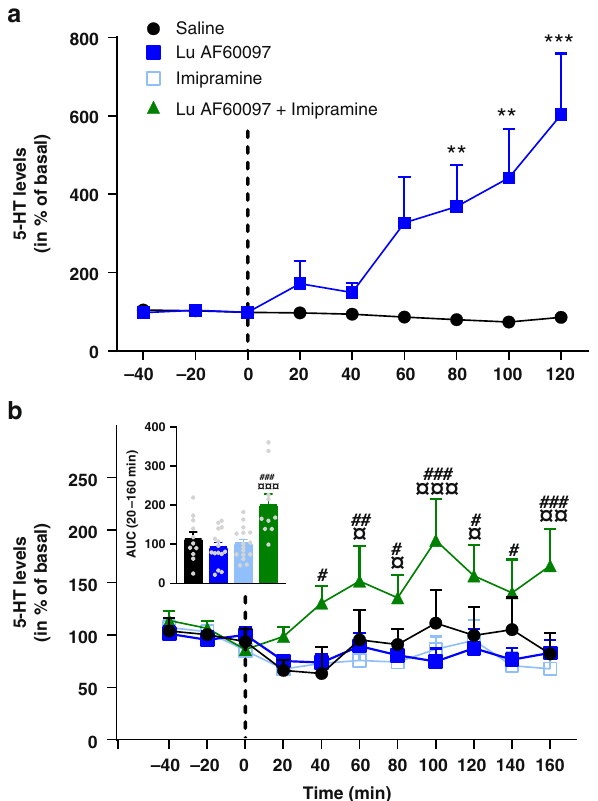
Fig. 6 Effects of Lu AF60097 and imipramine on 5-HT levels in rat hippocampus. a Changes in extracellular 5-HT levels after injection (dotted line) of 1 µ l (250 nM) Lu AF60097 (squares) or saline (circle) in ventral hippocampus of freely moving rats. The 5-HT levels show a continuous increase at all time points after the 40 min post injection bin to a maximum of 602 ± 156% of basal level (data are means ± S.E.M., n = 6). b Hippocampal perfusion of Lu AF60097 and imipramine synergistically increases extracellular 5-HT levels. Extracellular 5-HT levels were determined 40 min prior and 160 min after initiating (dotted line) a continuous perfusion of either saline (aCSF, circles), 1.9 µ M Lu AF60097 (closed squares), 0.36 µ M imipramine (open squares), 1.9 µ M Lu AF60097 + 0.36 µ M imipramine (triangles) in ventral hippocampus of freely moving rats. Inset: Area under the curve during perfusion (20 – 160 min) for the four conditions (matching colors to curves in main fi gure). The released 5-HT when perfused with both imipramine and Lu AF60097 is signi fi cantly increased (green bar). When perfused with either of the compounds alone (blue bars), the 5-HT levels are not different form saline (black bar). Data are means ± SEM (error bars), n = 9 – 15. The extracellular concentrations of 5-HT in both ( a ) and ( b ) are assessed by microdialysis and expressed as the percentage of the basal levels in the three fractions collected prior to perfusion start (dotted line). ** P < 0.01, *** P < 0.001 vs. saline; ¤ P < 0.05, ¤ ¤ P < 0.01, ¤¤¤ P < 0.001 vs. Lu AF60097; # P < 0.05, ## P < 0.01, ### P < 0.01 vs. imipramine; Bonferroni post-hoc test after signi fi cant RM two-way ANOVA or one-way ANOVA. Source data are provided as a Source Data fi